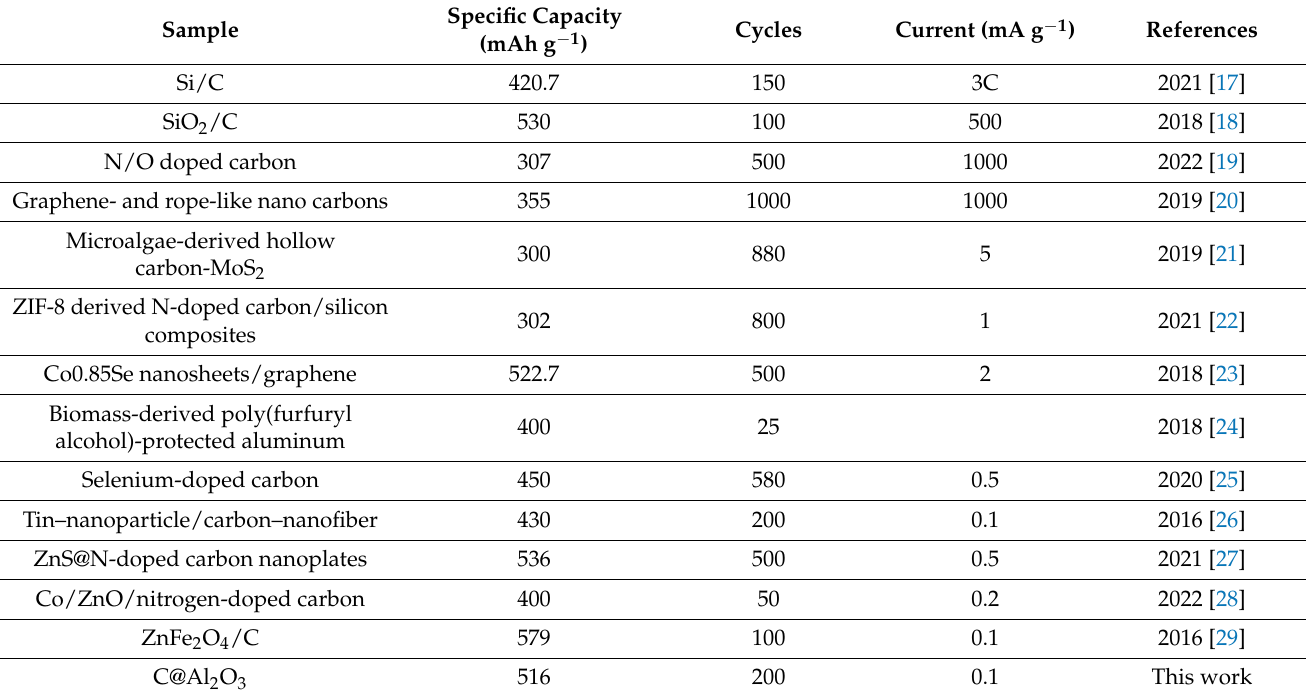
Table 1. Summary of the electrochemical performance of different carbon-based anodes in